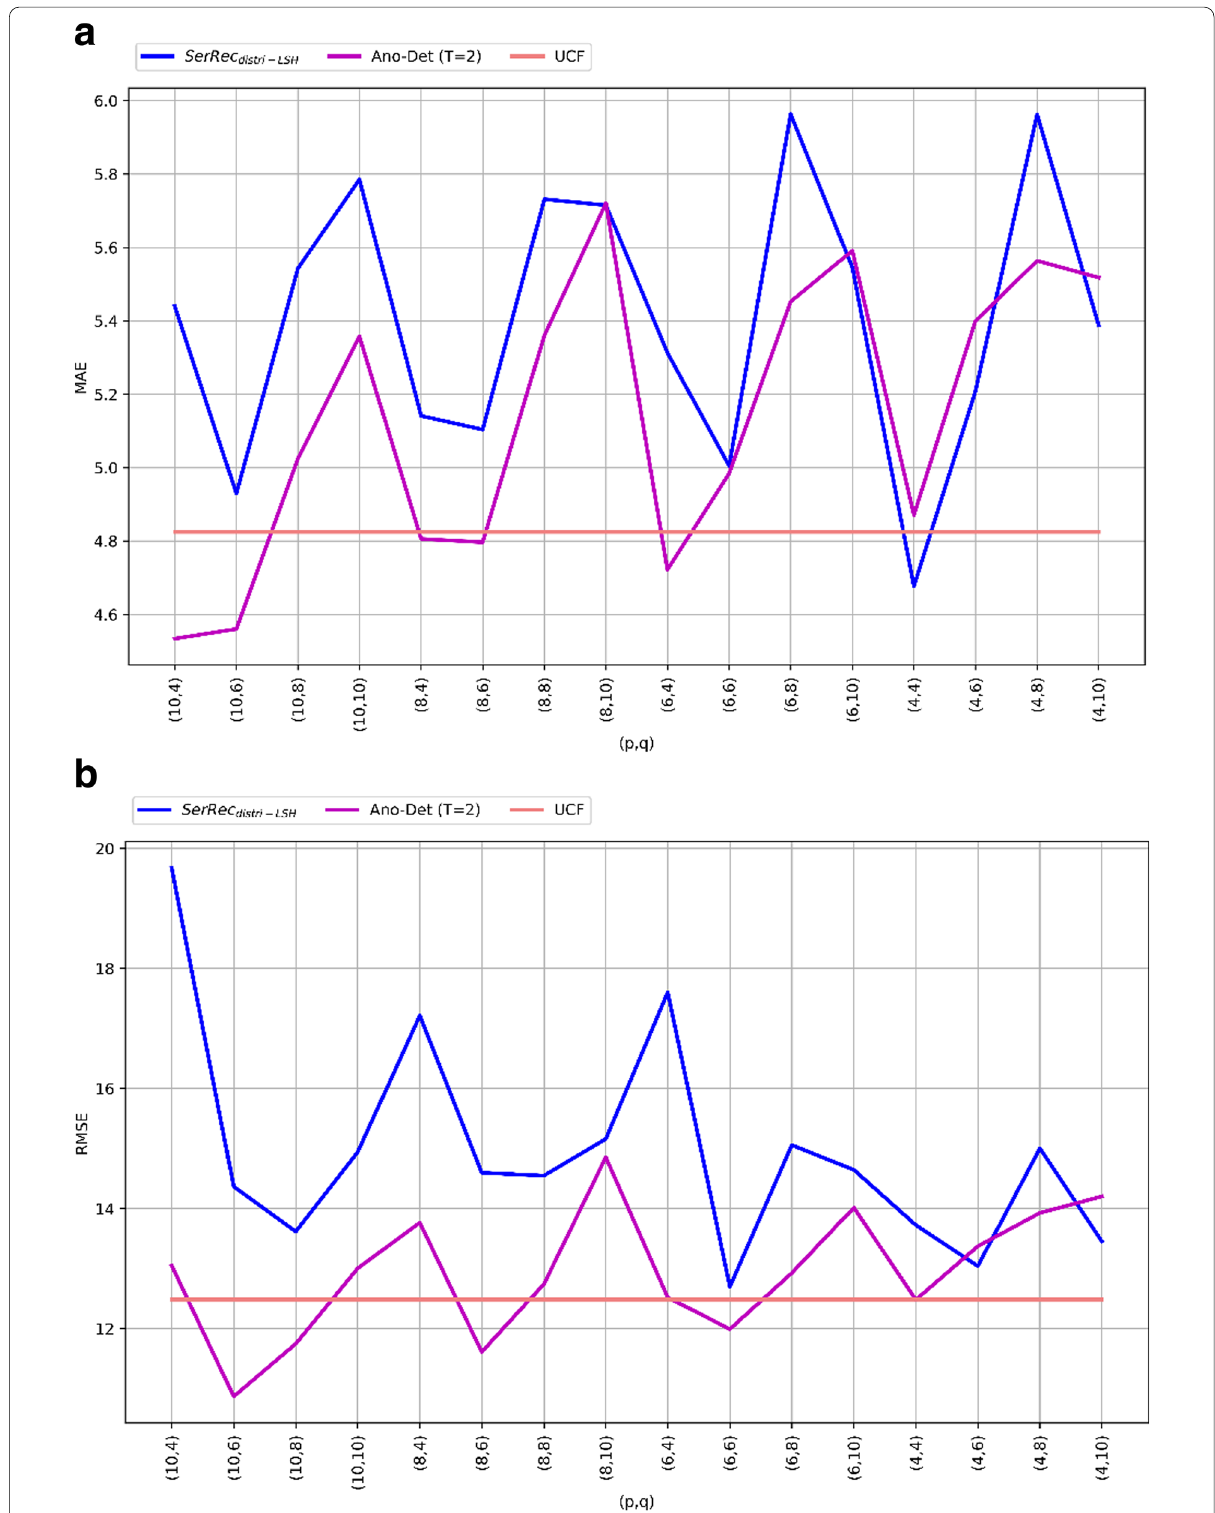
Fig. 2 Anomaly detection accuracy of three